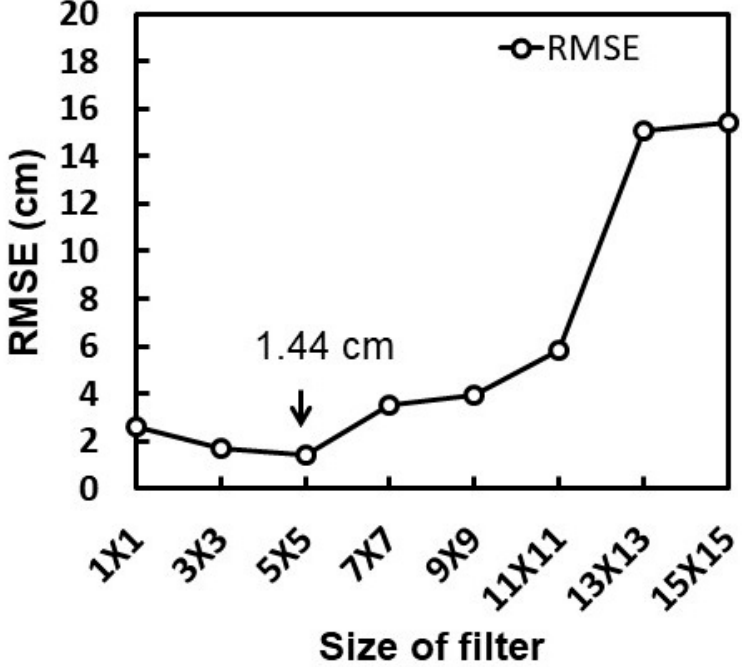
Figure 4. Root mean square error (RMSE) of ridge height produced from 3D models computed using different sizes of enlargement filters.